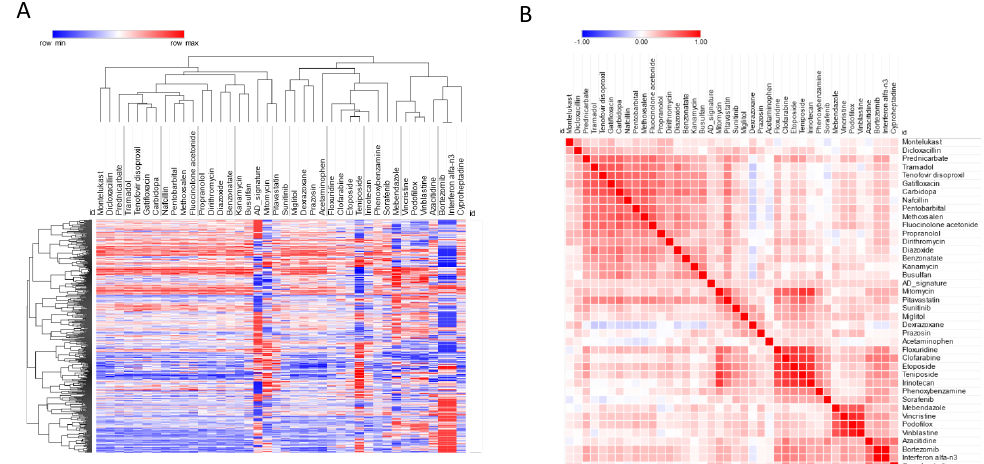
Figure 4. ( A ) Hierarchical clustering for the drugs predicted to predispose to AD; ( B ) similarity matrix for the drugs predicted to predispose to AD.